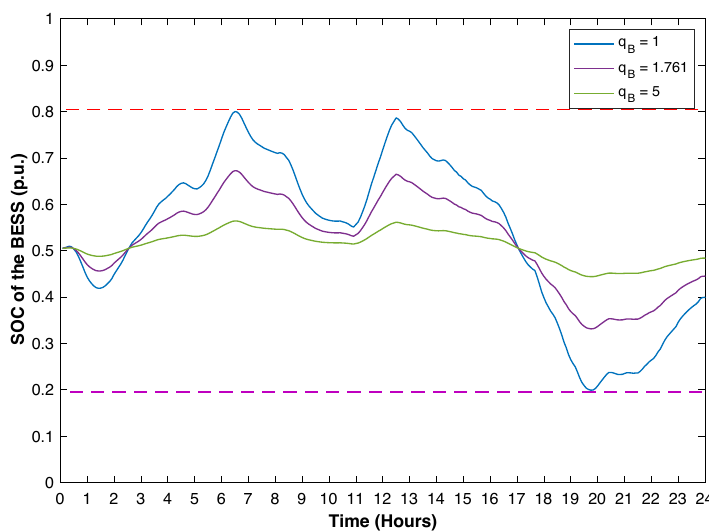
Figure 8. SOCs of BESS for q B values of 1, 1.761 and 5.